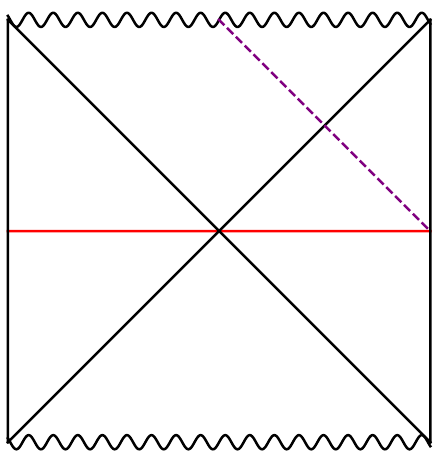
Figure 1 . Two di(cid:11)erent ways of perturbing the AdS black hole. The red horizontal line at t = 0 is where our perturbed initial data will be, whereas the purple dashed line (an ingoing null surface) is where the perturbation in [4]